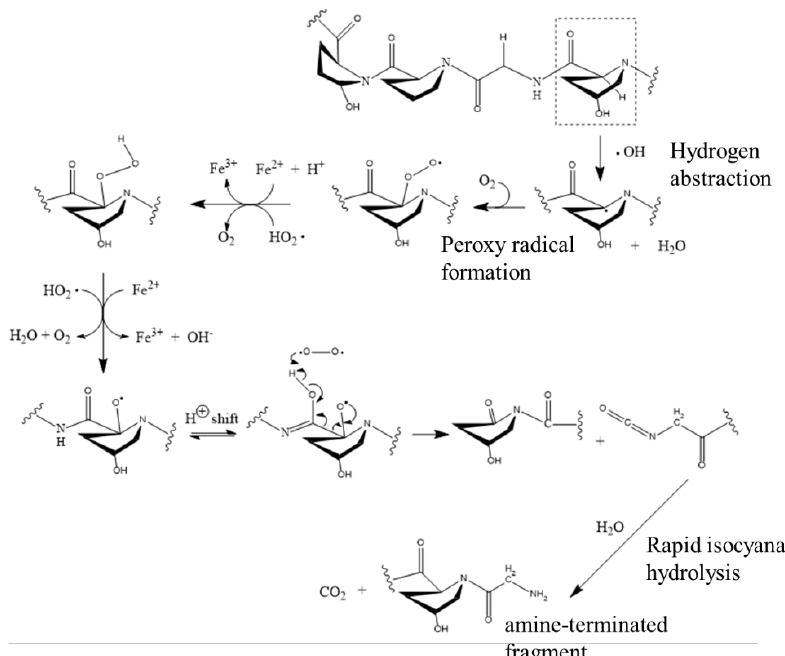
Figure 7. The chemical mechanism of the plasma scalpel inducing collagen fragmentation. Carbon- nitrogen cleavage occurs via OH extraction of hydrogen, hydroxylation of carbon, and hydrolytic cleavage of C-N bonds.